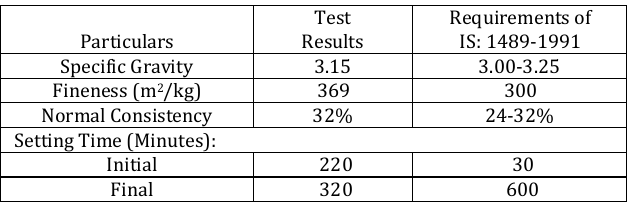
Table 1: Physical properties of procured OPC